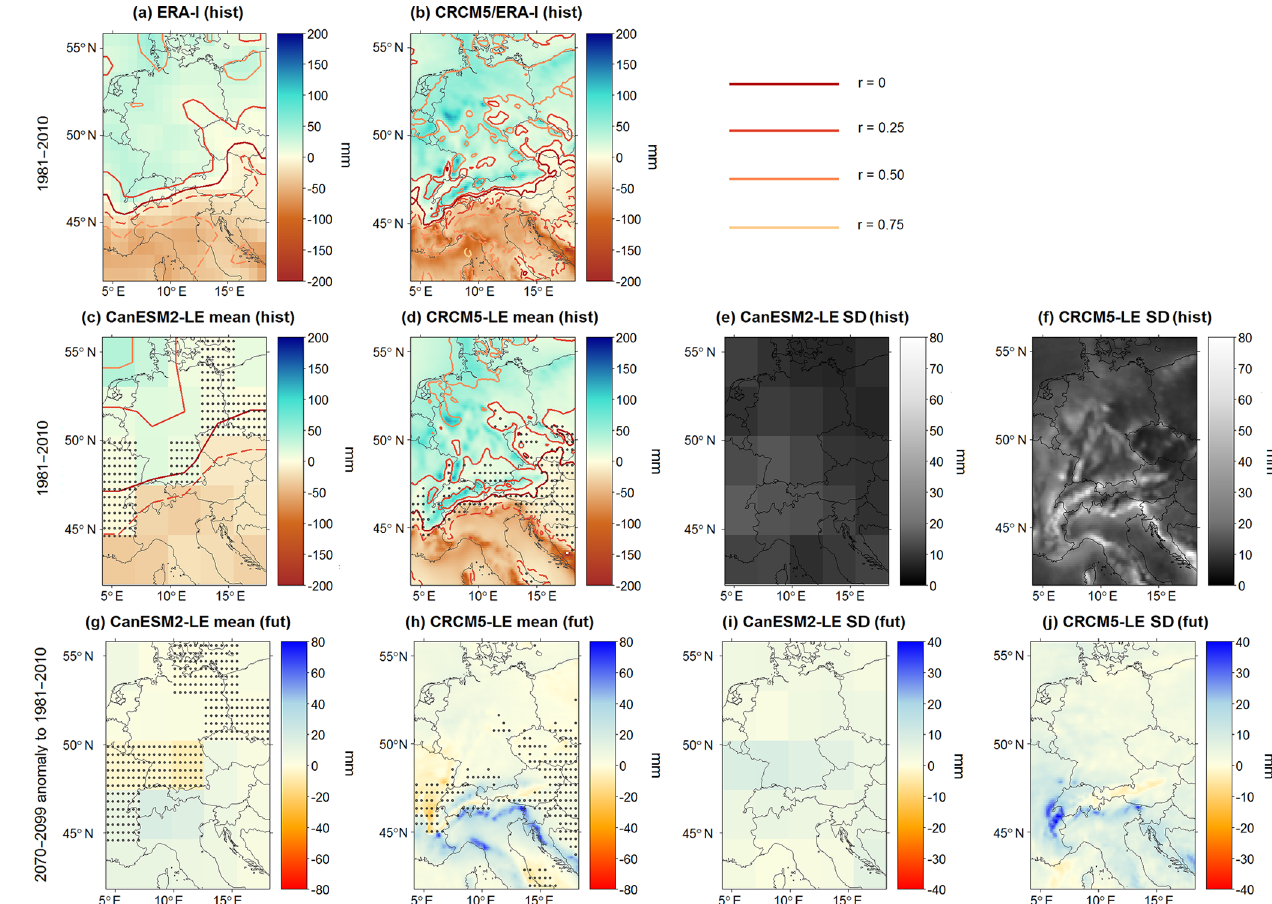
Figure 8. Like Figs. 6 and 7 but for PR sum ( α 1 in mm). Dashed lines of correlation coefficients indicate negative values. Note that the difference maps for CanESM2-LE and CRCM5-LE mean are calculated using absolute α 1 values and that the color bar in the bottom row is flipped compared with Figs. 6 and